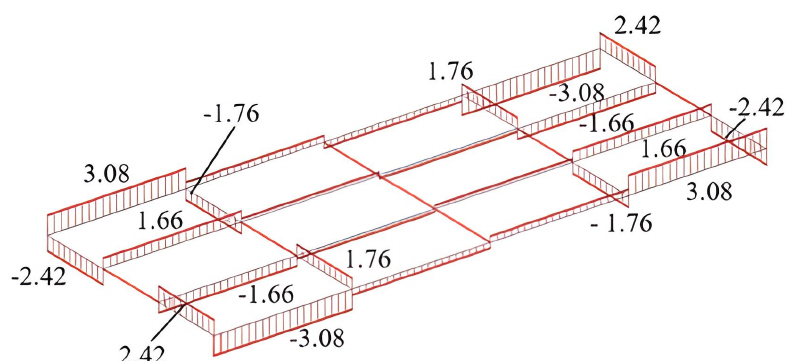
Figure 4. Diagram of the bending moments on the module (kN·m).